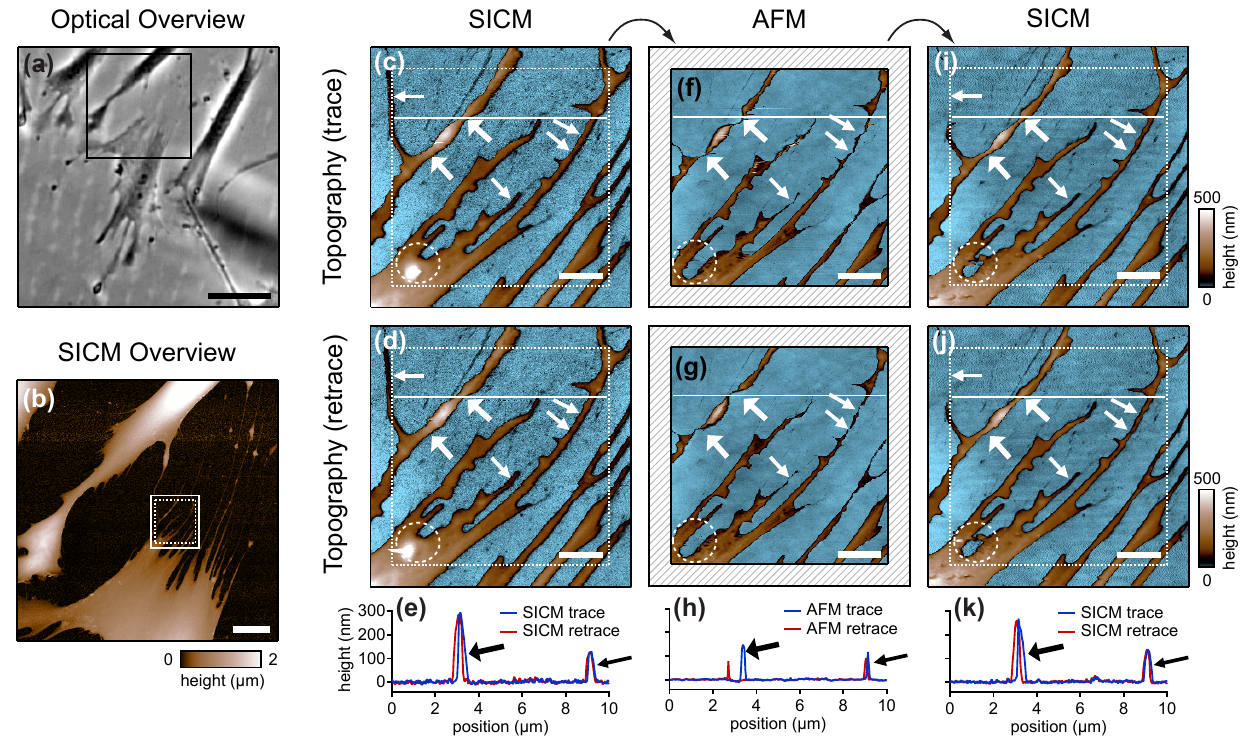
Figure 7. Comparison of SICM and AFM in AC- and tapping-mode. Extensions of a fixed fibroblast (box in b , corresponding phase contrast image in a ) were imaged both with SICM and AFM repeatedly, an SICM overview image is provided in ( b ). ( c , f , i ) Topography images obtained by SICM ( c ), AFM ( f ) and again by SICM ( i ) show that small objects appear thinner and lower in the AFM image (small diagonal arrows). Bold white arrows mark regions less attached to the substrate that are shifted towards the scanning direction by AFM, compare the retrace scan ( g , opposite scanning direction) and the corresponding profiles ( h ). In contrast, SICM traces and retraces match. The horizontal arrow and the dashed circle mark areas that potentially have been destroyed by the AFM scan, since they are not visible in the second SICM recording. Reprinted with permission from [38]. Copyright 2011 American Chemical